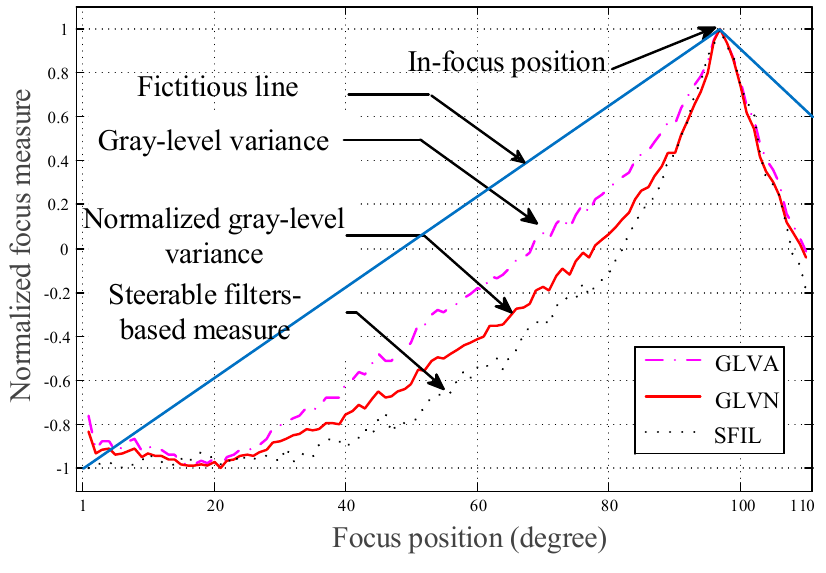
Figure 3. Sharpness to servomotor rotation angle.